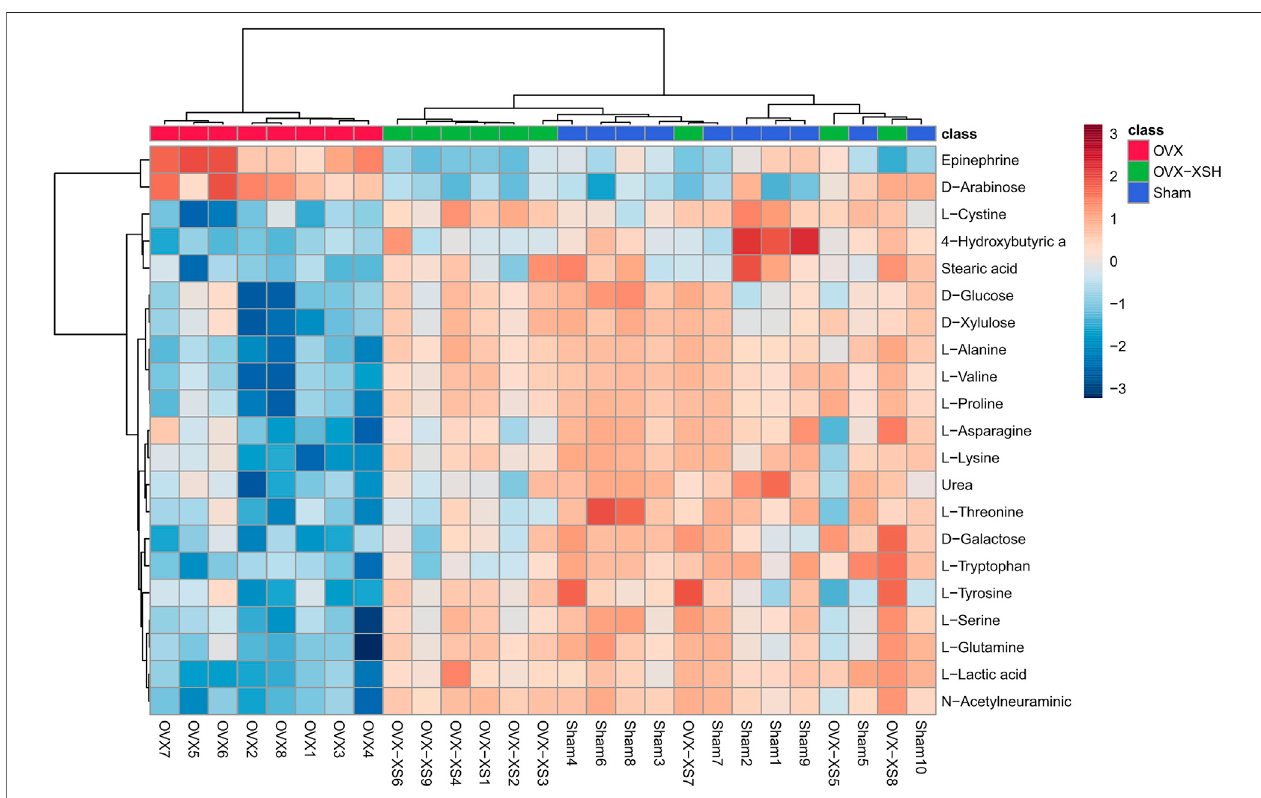
FIGURE 9 | Discriminating metabolites differentiated in sham, OVX, and OVX-XSH groups. FC > 1.2 or < 0.83, p -value < 0.05 and VIP-value > 1.0, n (cid:2) 8 – 10 per group, OVX-XSH (97.2 mg/kg).